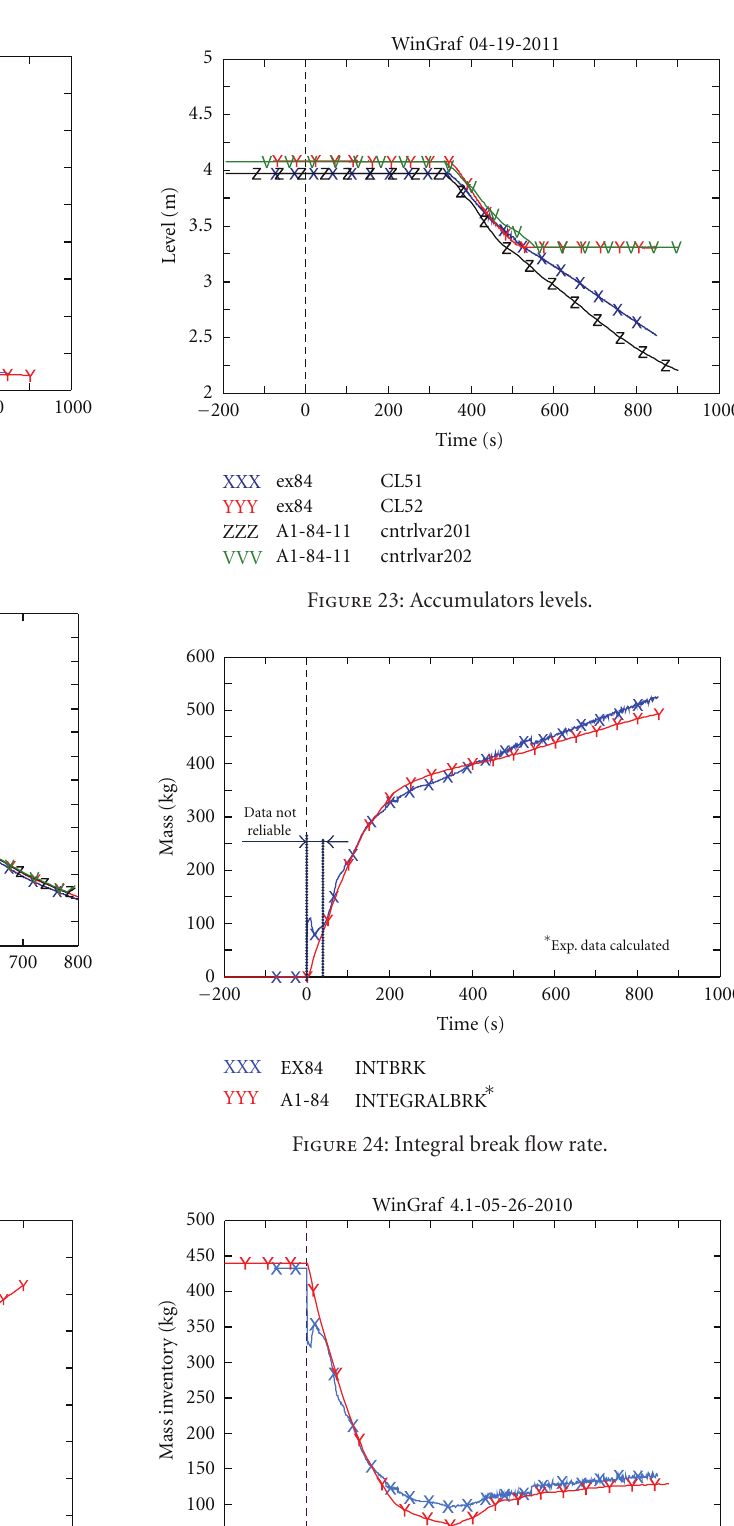
Figure 25: Primary system